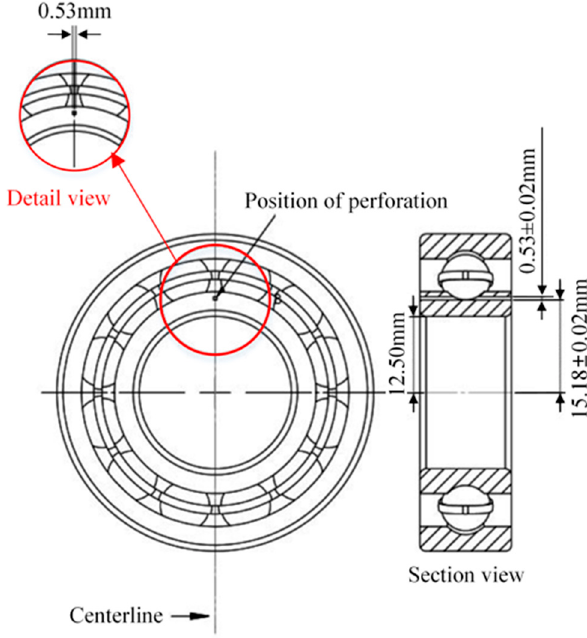
Figure 7. Schematic diagram of bearing inner ring defect.